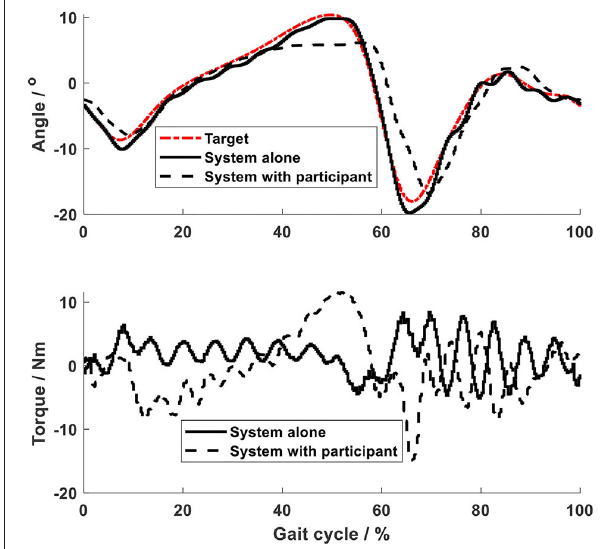
FIGURE 10 | Ankle